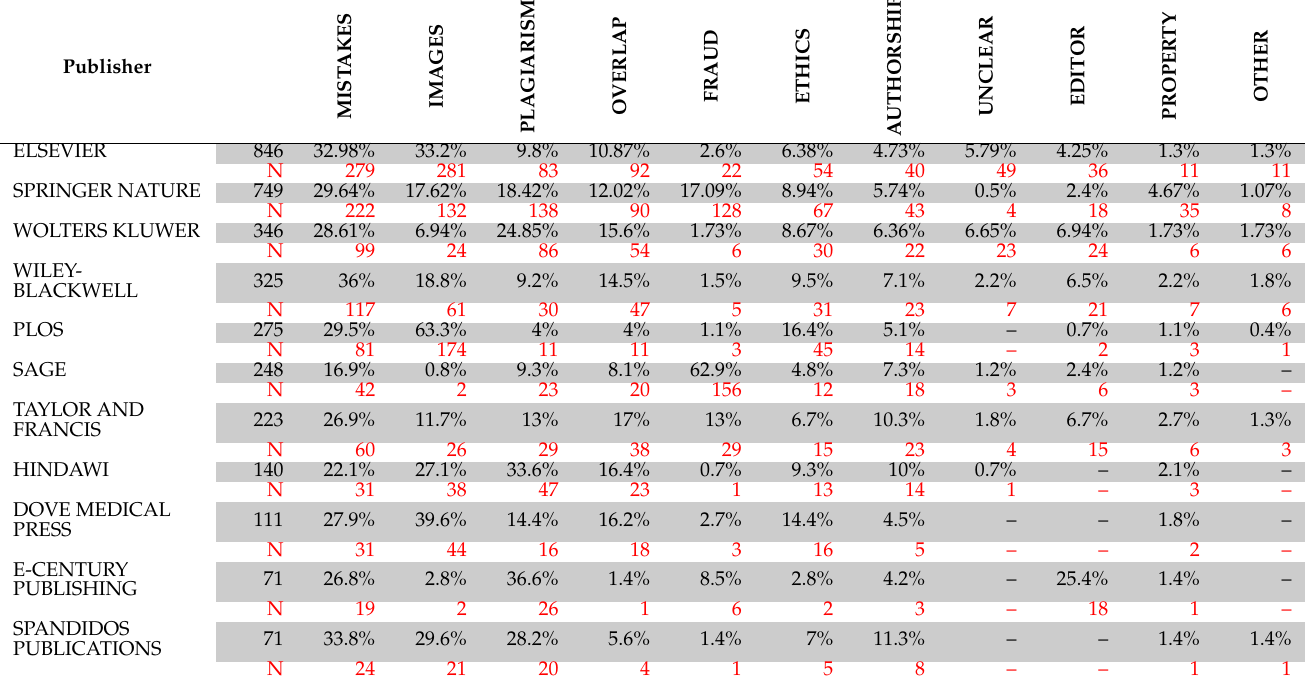
Table 4. Retraction reasons for top 11 publishers (3405 retracted papers, 70.3%).